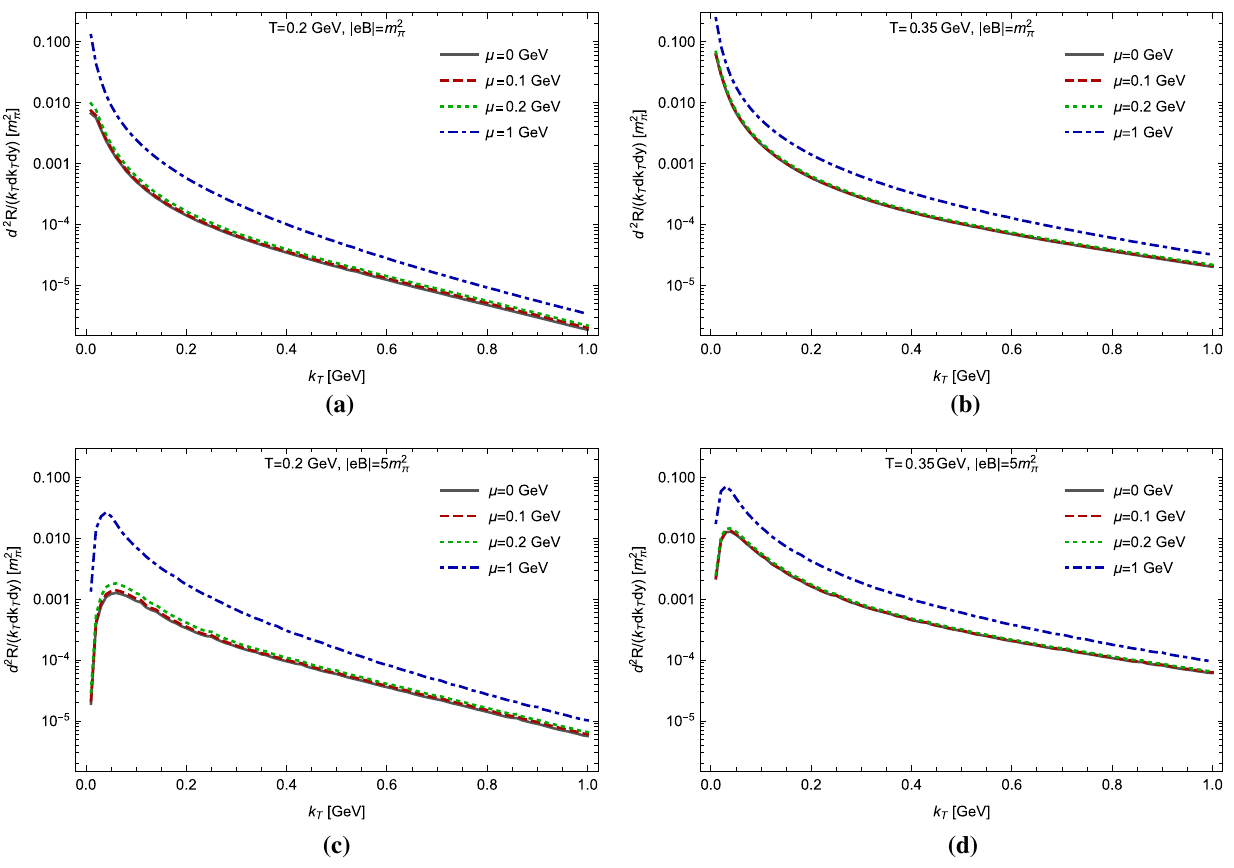
Fig. 1 Photon production rate as a function of the transverse momen- tum k T for four different values of the chemical potential: μ = 0 (gray lines), μ = 0 . 1 GeV (red dashed lines), μ = 0 . 2 GeV (green dot- ted lines), and μ = 1 GeV (blue dot-dashed lines). The left panels